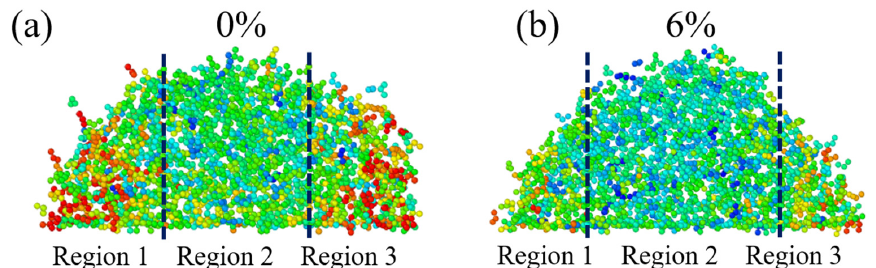
Figure 3. Displacement distribution of physiological saline at different NaCl concentrations, ( a ) 0% NaCl and ( b ) 6% NaCl.